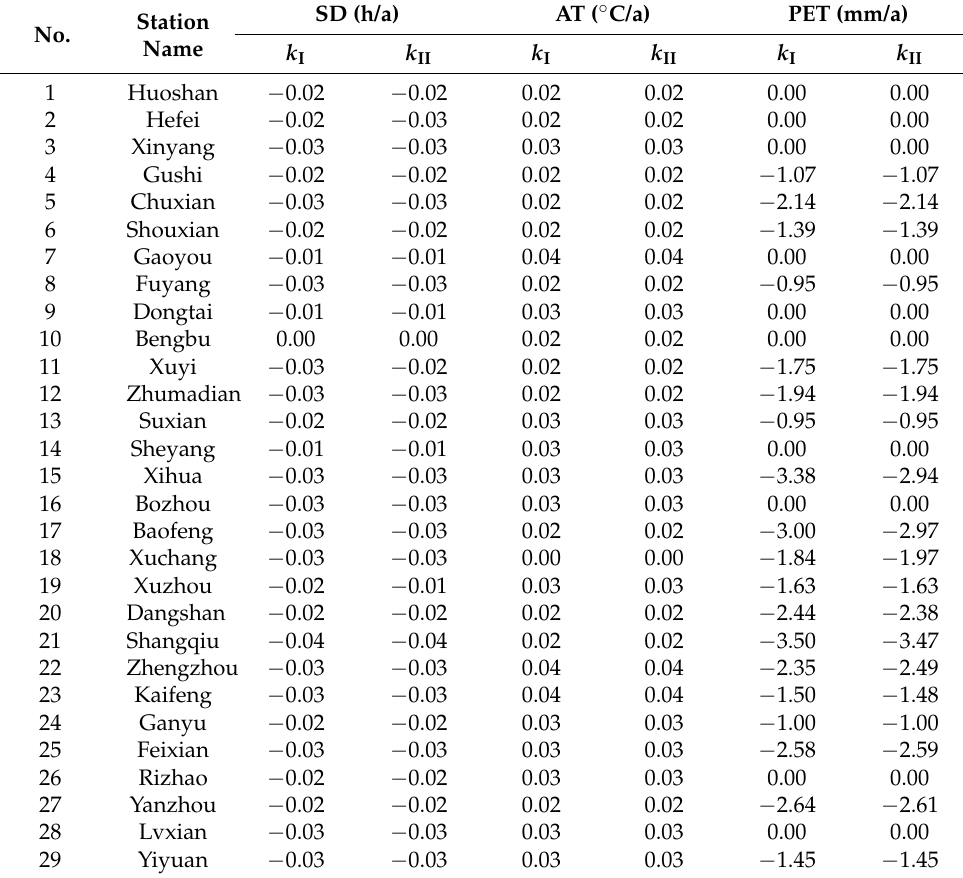
Table 4. Trend slopes for the annual SD, AT, and PET series in the HRB derived by the trend tests based on the MMK test and OW operation at the 5% significance